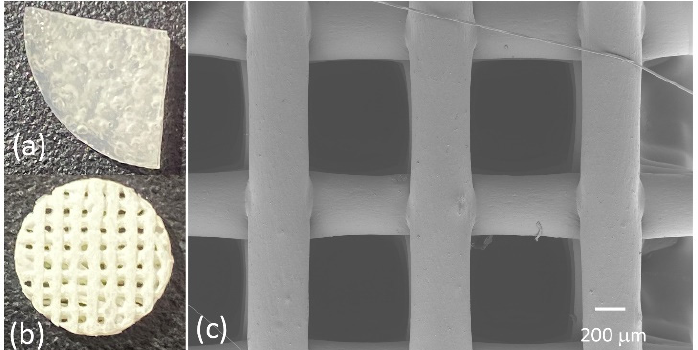
Figure 1. ( a , b ) Representative images of the samples fabricated using solvent casting and 3D bioplotting techniques, respectively, ( c ) a top-view image of a 3D bioplotted scaffold, as seen via SEM.